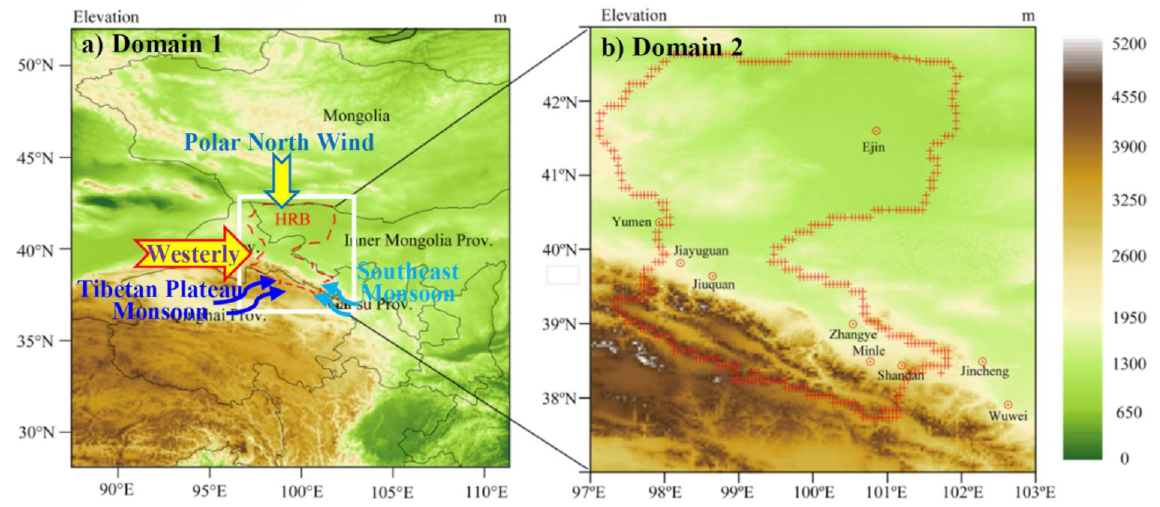
Figure 1. The study region: ( a ) the location of the HRB; ( b ) the research domain. As shown in Figure 1, the water-vapor transport in the HRB can be controlled by westerly wind, polar north wind, the Tibetan Plateau monsoon and the Southeast monsoon. However, water-vapor transport by the Tibetan Plateau and Southeast monsoons is ob- structed by the Qilian Mountains because of their high elevation, so part of it is converted into precipitation in the region south of the HRB, and another part turns eastward [33–35]. Therefore, the water-vapor transport by the Tibetan Plateau and Southeast monsoons is negligible in the